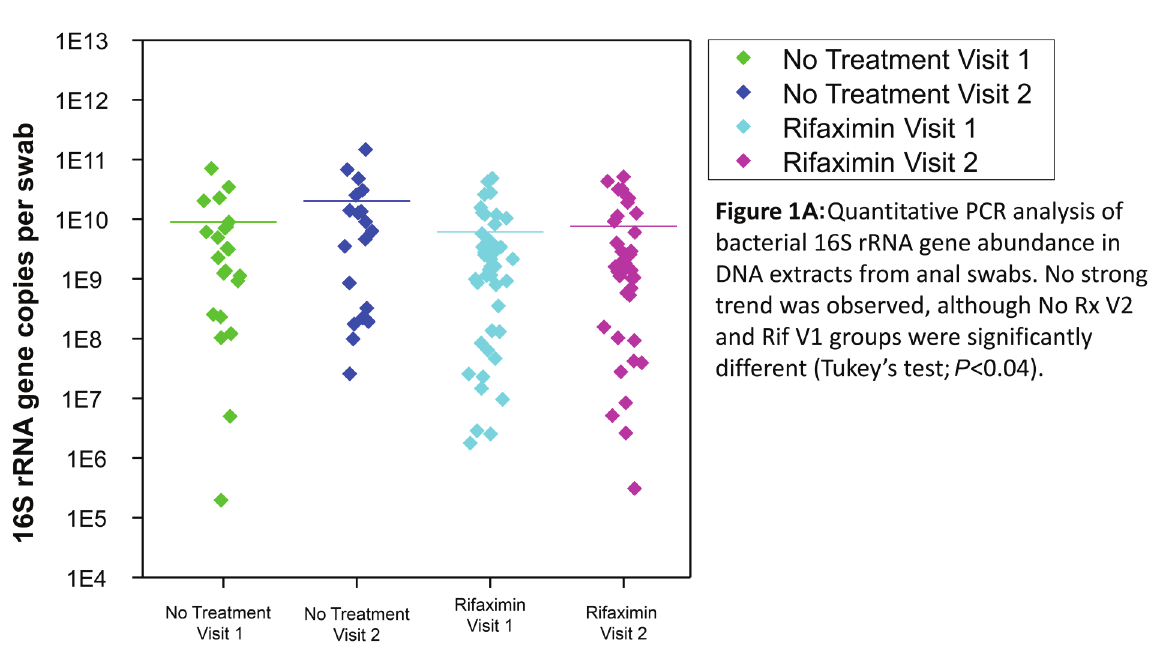
Figure 1A . Quantitative PCR analysis of bacterial 16S rRNA gene abundance in DNA extracts from anal swabs. No strong trend was observed, although no-treatment visit 2 and Rifaximin visit 1 groups were significantly different (Tukey’s test; P <